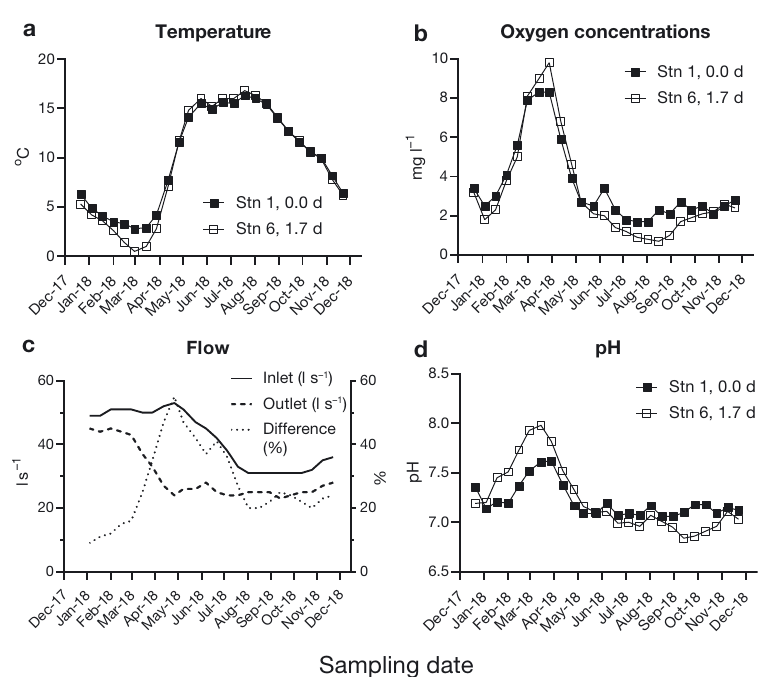
Fig. 2. Seasonal and longitudinal changes (only Stns 1 and 6 shown for simplic- ity) in wetland (a) temperature, (b) oxygen concentration, (c) flow conditions, and (d) pH during monitoring (1-point measurements obtained in the morning when collecting samples). Data are shown as 3-point moving